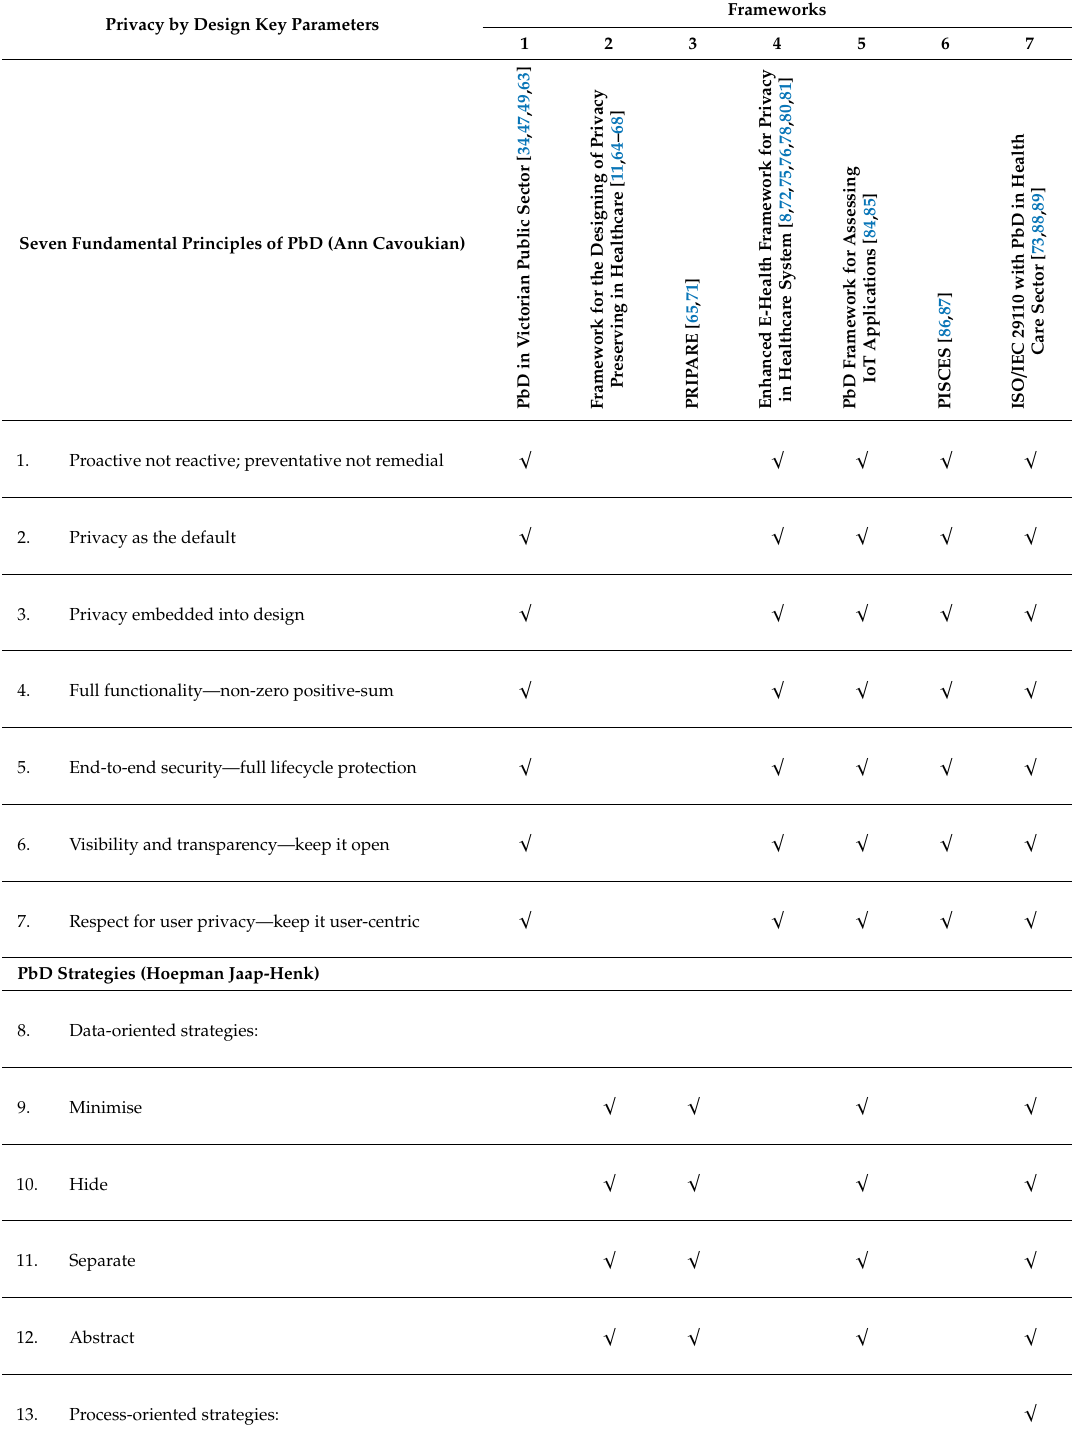
Table 3. A comparative view on existing privacy by design